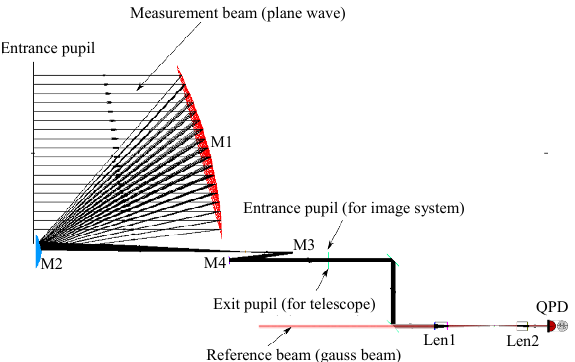
Fig. 9 Simplified schematic of telescope and optical bench. The entrance pupil of the telescope system concides with the exit pupil of image system.